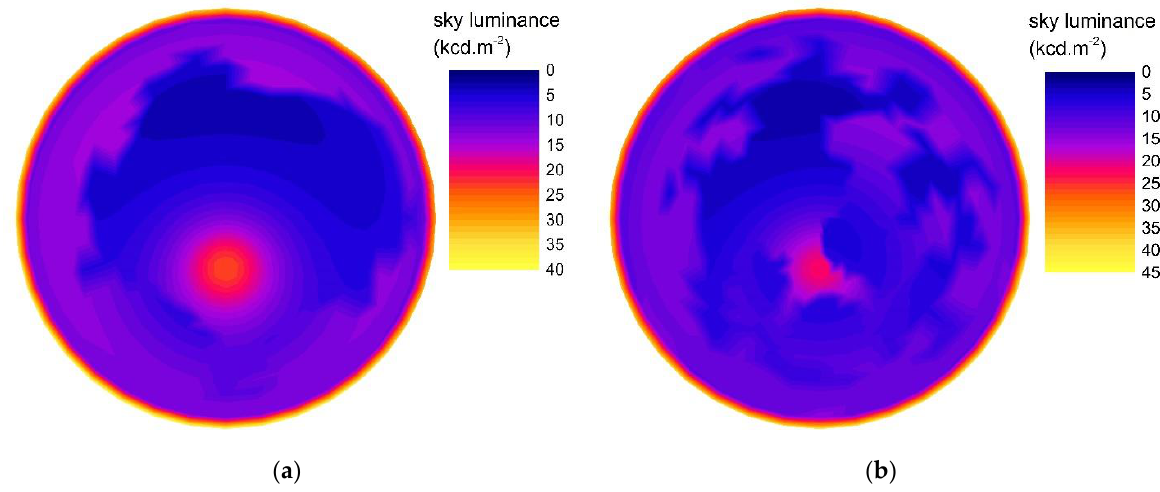
Figure 4. Sky luminance patterns for two simulated cloud arrays differing in their distribution and the cloud parameters: ( a ) case 1 — the cloud radius 0.5 km, the base altitude 0.5 km; ( b ) case 2 — the cloud radius 0.25 km, the base altitude 1 km. The cloud fraction equal to 0.3 and the solar zenith angle of 40° were assumed in both cases.